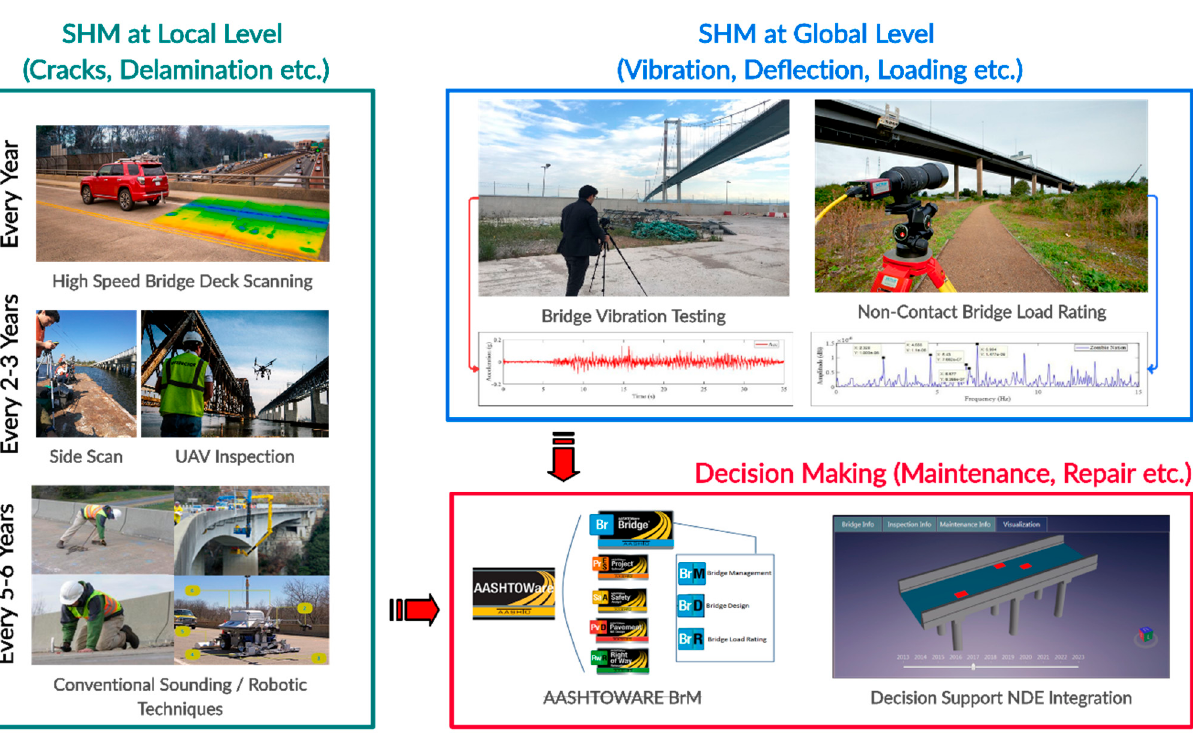
Figure 1. SHM at local and global levels using noncontact methods and advanced decision making.